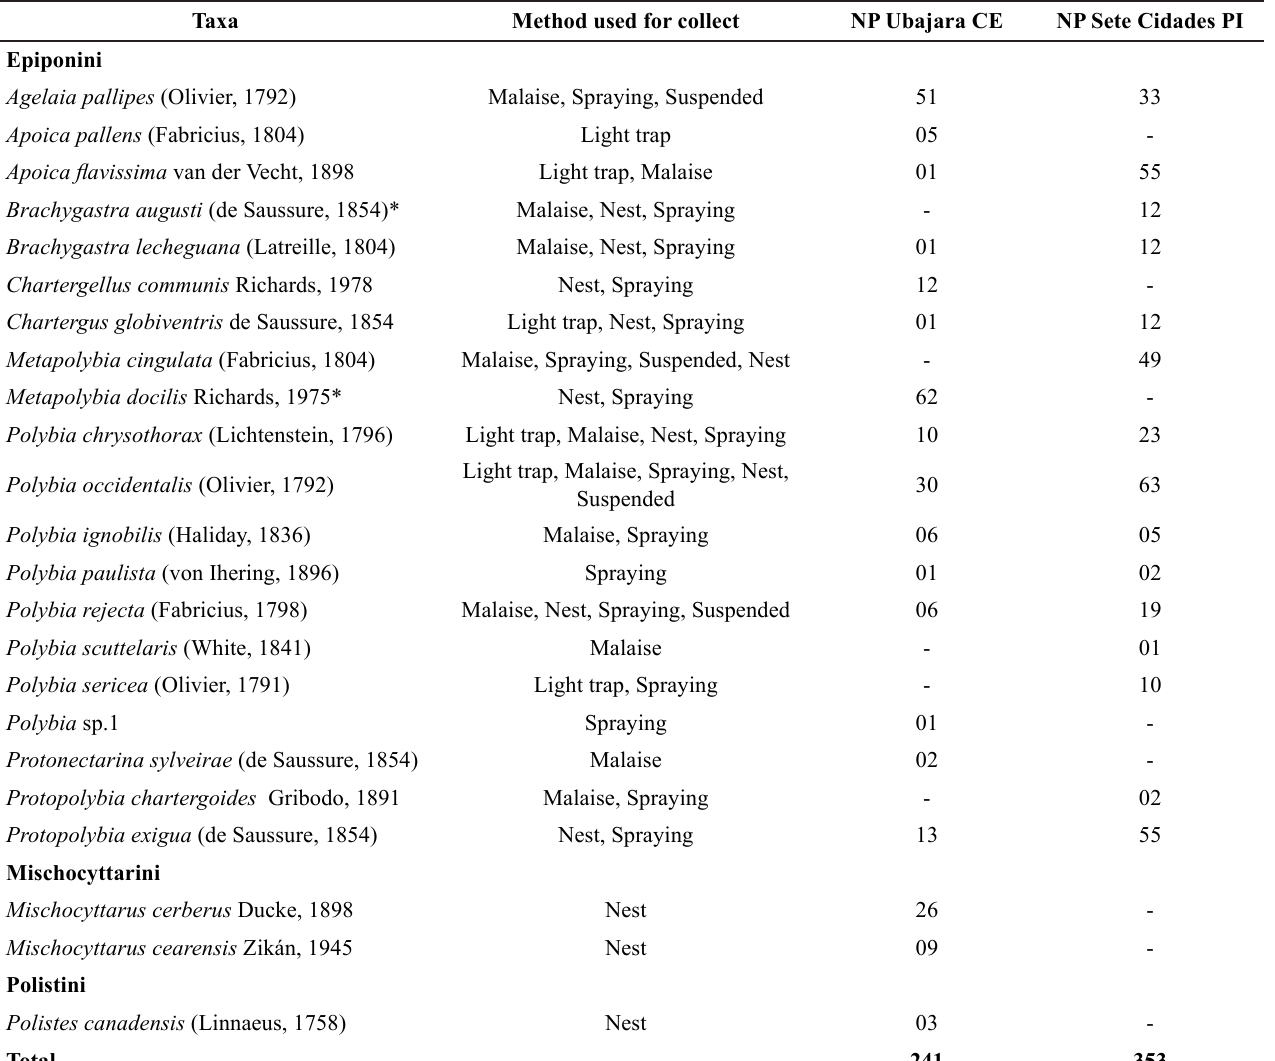
Table 1 . Social wasps collected in Sete Cidades National Park (Piauí state) and Ubajara National Park (Ceará state) and methods used for collect each species: (* New record for Caatinga